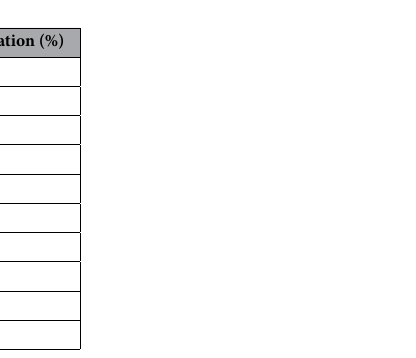
Table 9. Summary of failure modes, young’s modulus, and